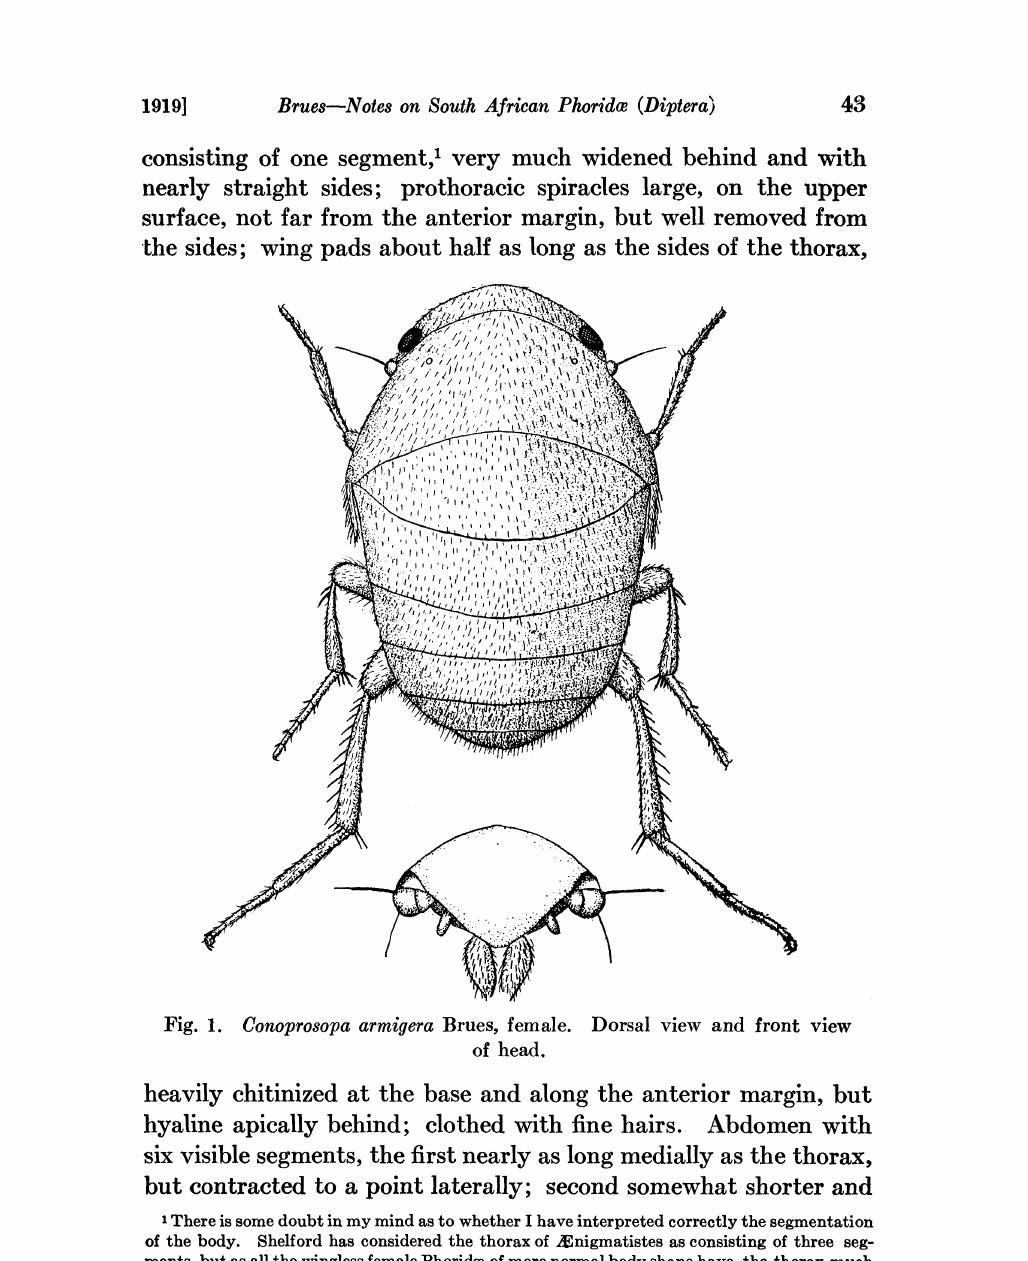
Fig. 1. Conoprosopa armigera Brues, female. Dorsal view and front view of head. heavily chitinized at the base and along the anterior margin, but hyaline apieally behind; clothed with fine hairs. Abdomen